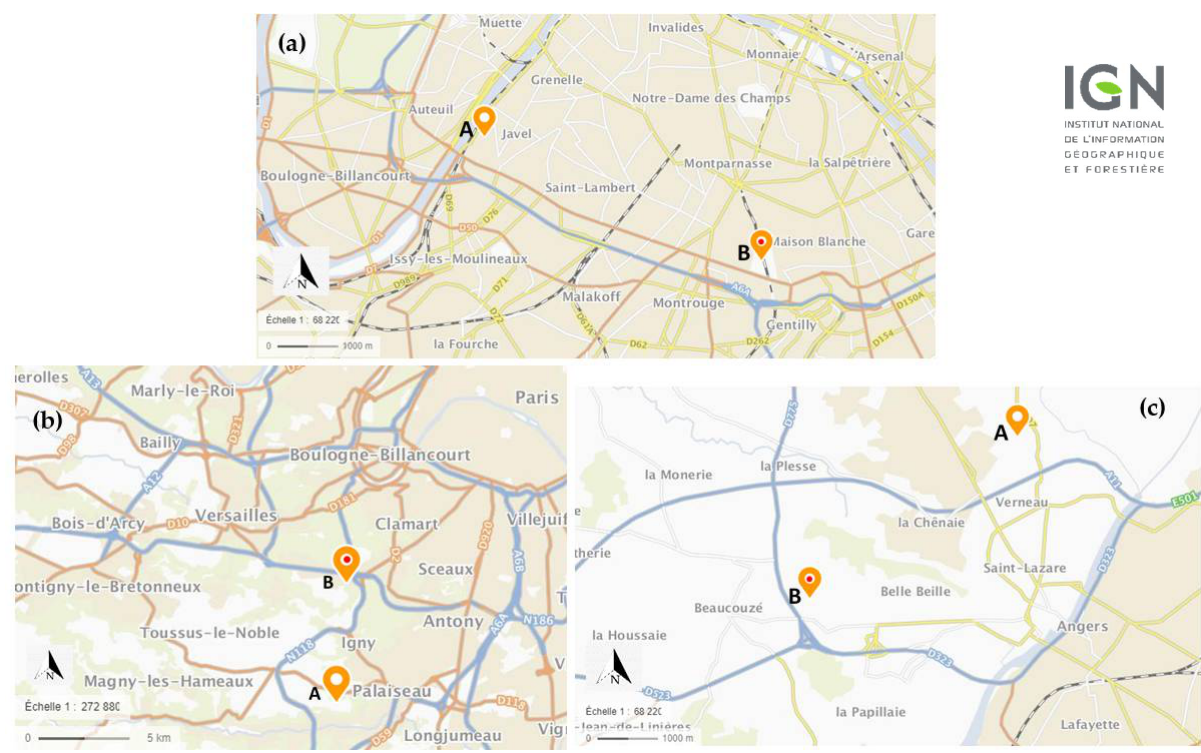
Figure 2. Maps showing the location of the LOAC (A) and the corresponding weather station (B). ( a ) In Paris, 5 km apart; ( b ) In Palaiseau, 7.5 km apart; ( c ) In Angers, 4.1 km apart (@ IGN 2020).